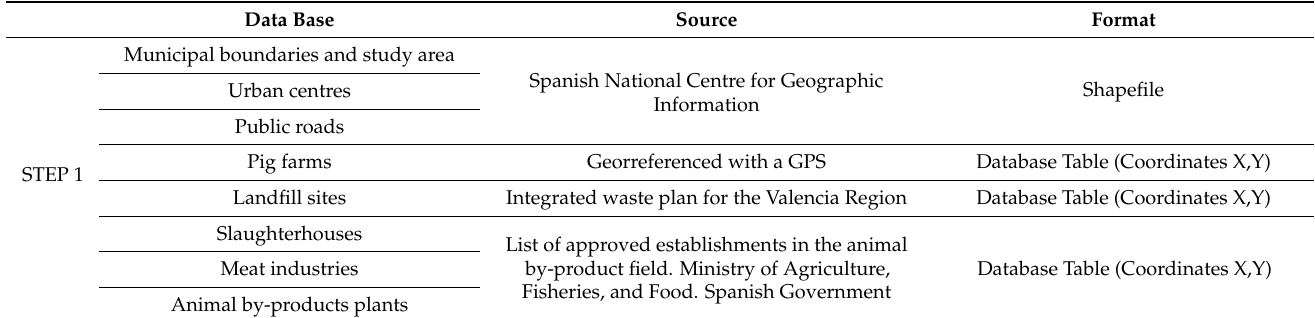
Figure 2. Flowchart of the land use suitability analysis for pig development. Table 2 describes the sources and formats of the variables considered. Table 2. Source and format of the variables considered in STEPs 1, 2, and